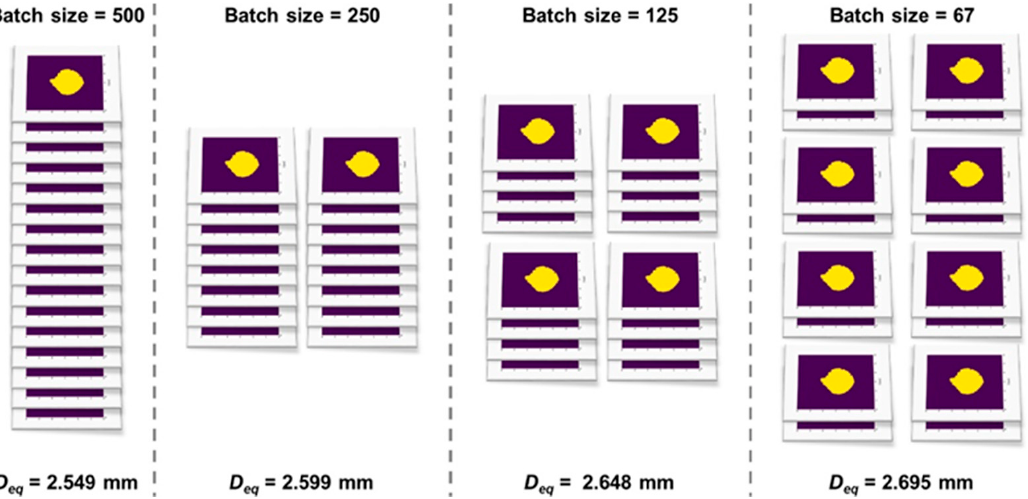
Figure 8. Examples of equivalent diameters D eq of different batch sizes, showing the proposed methodology for estimation of the diameter reduction.